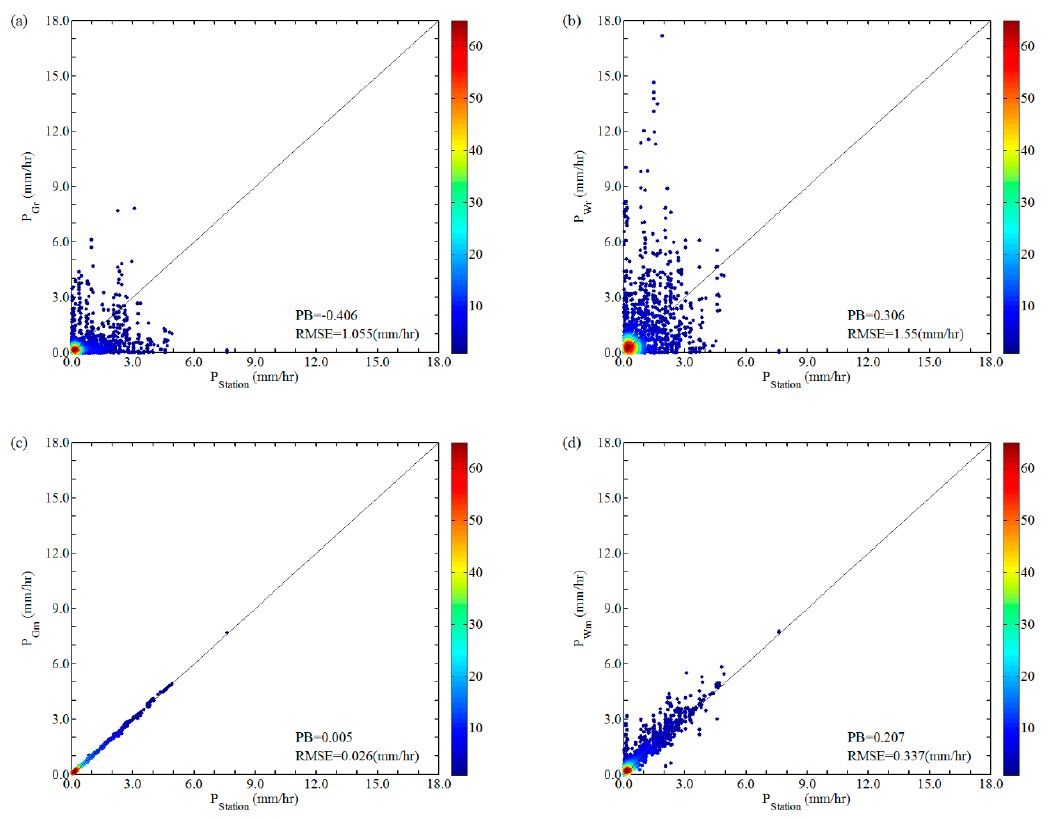
Figure 4. Comparison of hourly ( a ) Gr, ( b ) Wr, ( c ) Gm and ( d ) Wm rainfall data with the station observations.